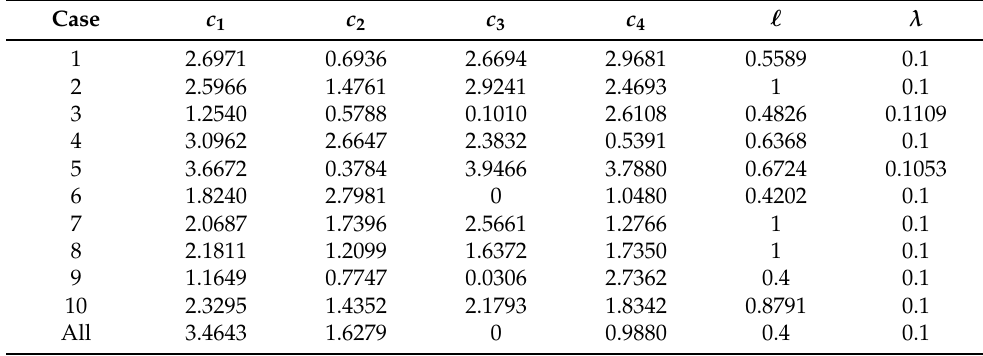
Table A1. Hyper-parameter optimization using Matérn ( nu = 2.5, (cid:96) = 1.0 ) as kernel.